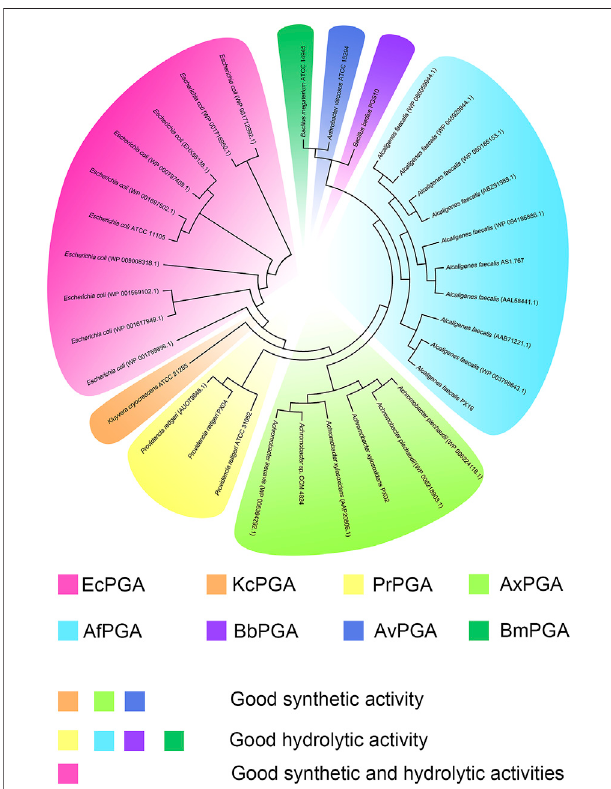
FIGURE 3 | The phylogenetic tree of industrially relevant PGAs reported in the literature and their strain origins.